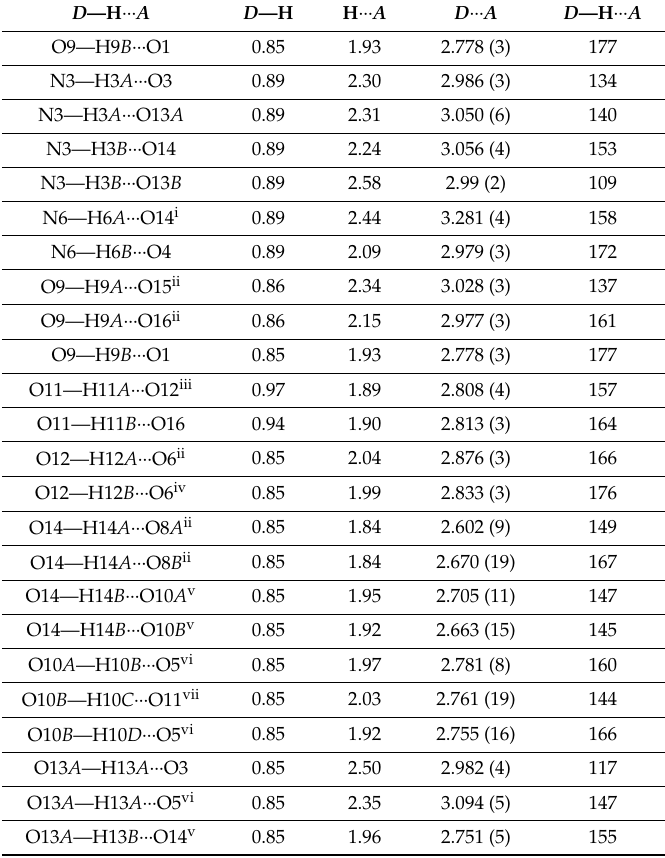
Table 3. Hydrogen bond distances and angles for Compound 1 [Å and ◦